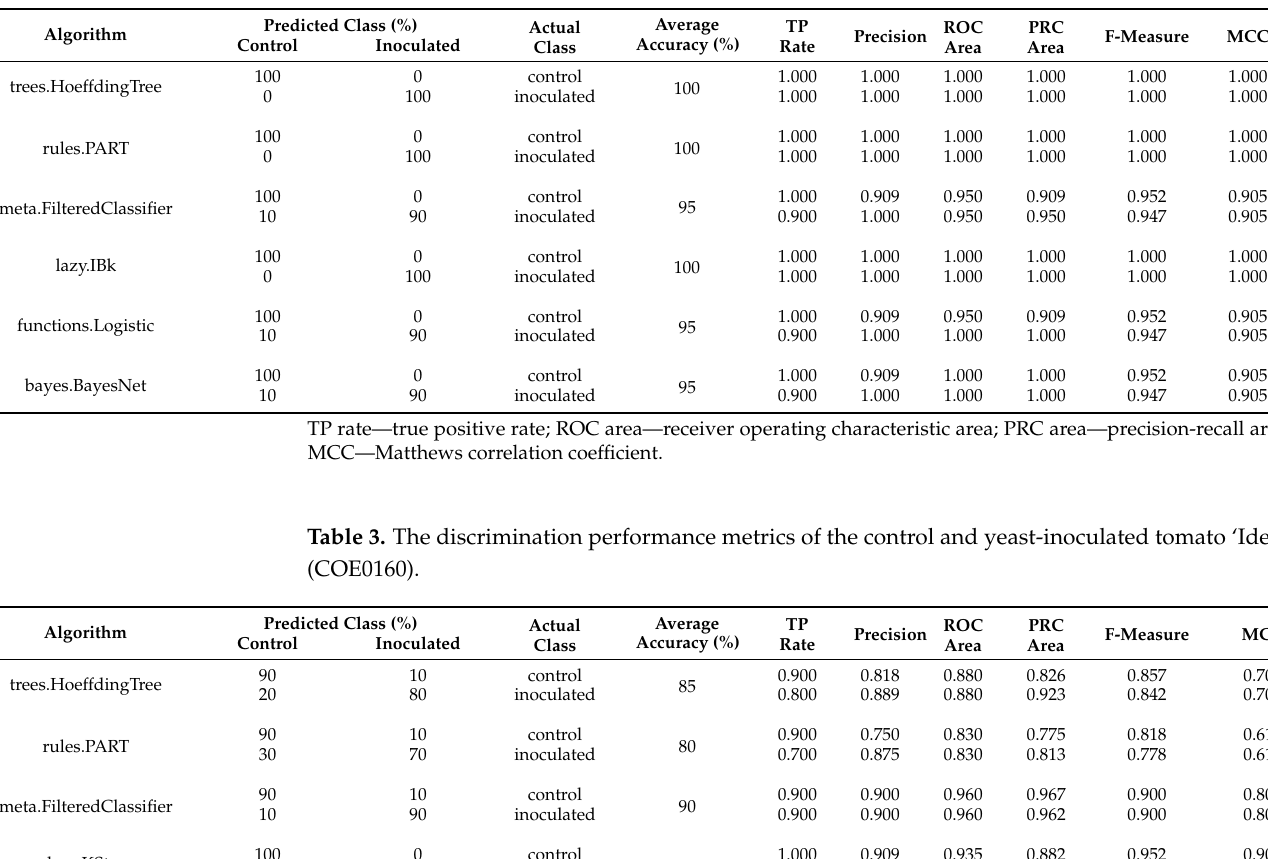
Table 2. The discrimination performance metrics of the control and yeast-inoculated tomato ‘Pikador’ (COE0159).